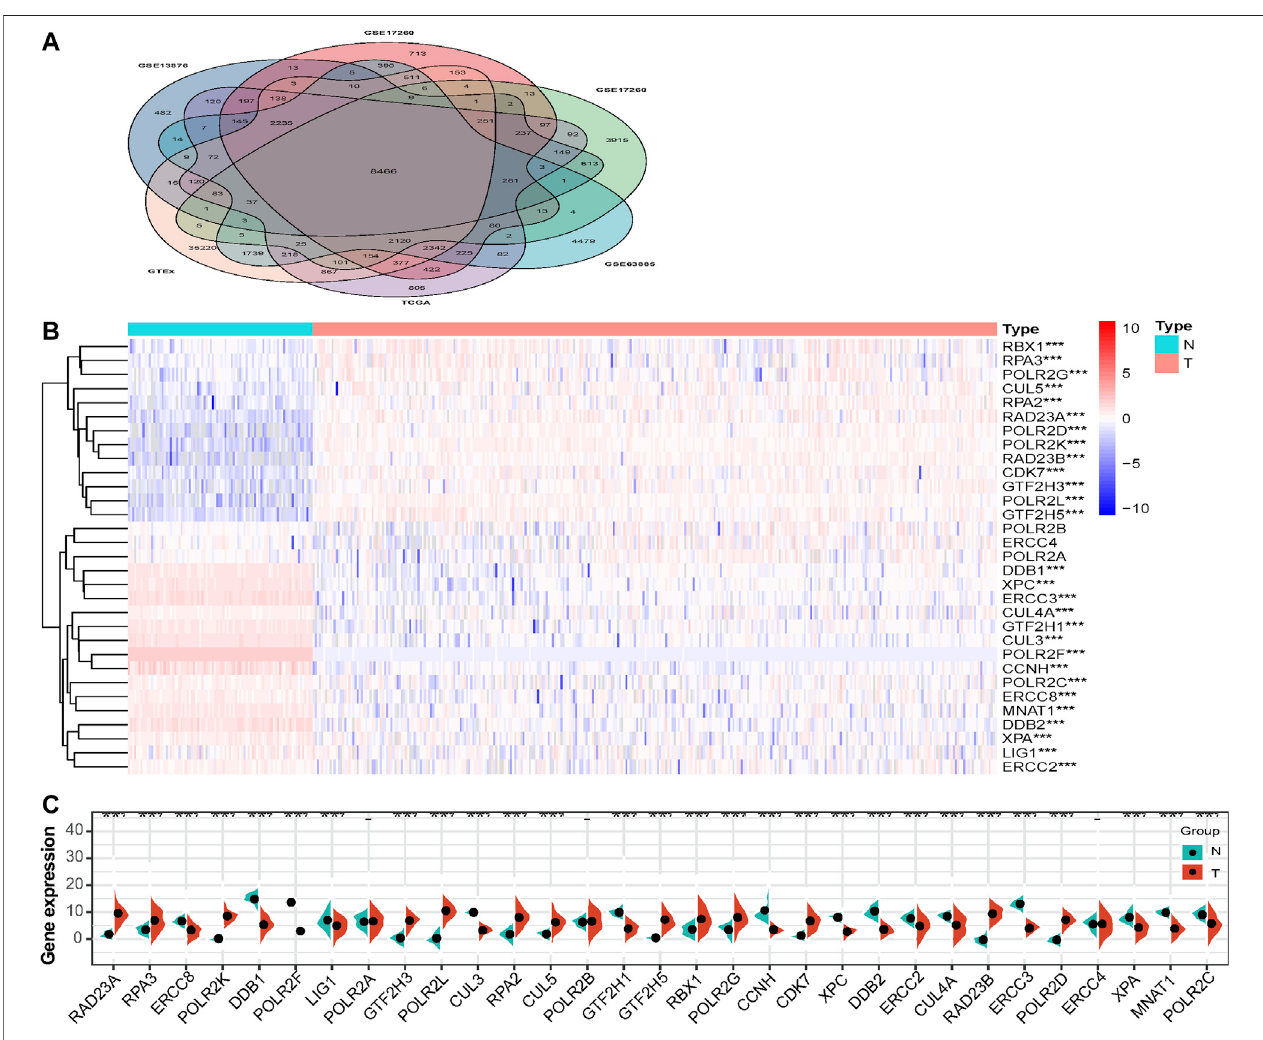
FIGURE1| Theexpression levels ofNER-relatedgenesbetweentumor samplesandnormalsamplesinTCGA HGSOCcohortandGTEx normalovarycohort. (A) Venn diagram displays that 8,466 shared genes were contained in the TCGA, GTEx, and four GEO datasets. (B) The TCGA and GTEx databases were used to jointly analyze 31 NER-related genes and the heatmap was used to visualize the expression levels of these genes in each clinical sample. (C) The violin-plot shows the expression of 31 NER-related genes between tumor tissues and the normal tissues. p p < 0.05, pp p < 0.01, and ppp p < 0.001. Abbreviation: HGSOC: high-grade serous ovarian cancer; TCGA: The Cancer Genome Atlas; GTEx: the Genotype-Tissue Expression project; GEO: Gene Expression Omnibus; NER: Nucleotide excision repair.